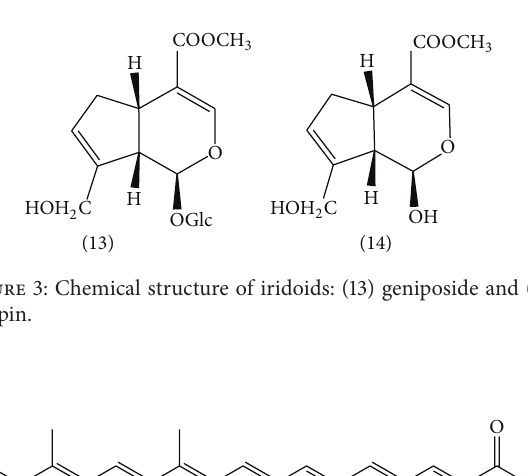
growth. Its pharmacological activities have been documented to be anticancer [49], anti-inflammatory [50], and cardiovas- cular effects [51].